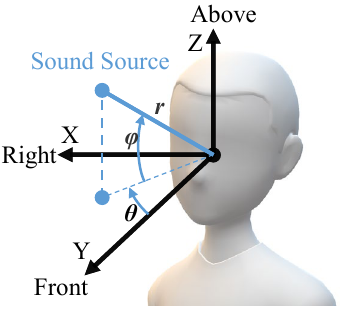
Figure 2. Right-handed spherical coordinate that used to represent the spatial location of sound